Question: Judging by this figure, is the value going up or going down?
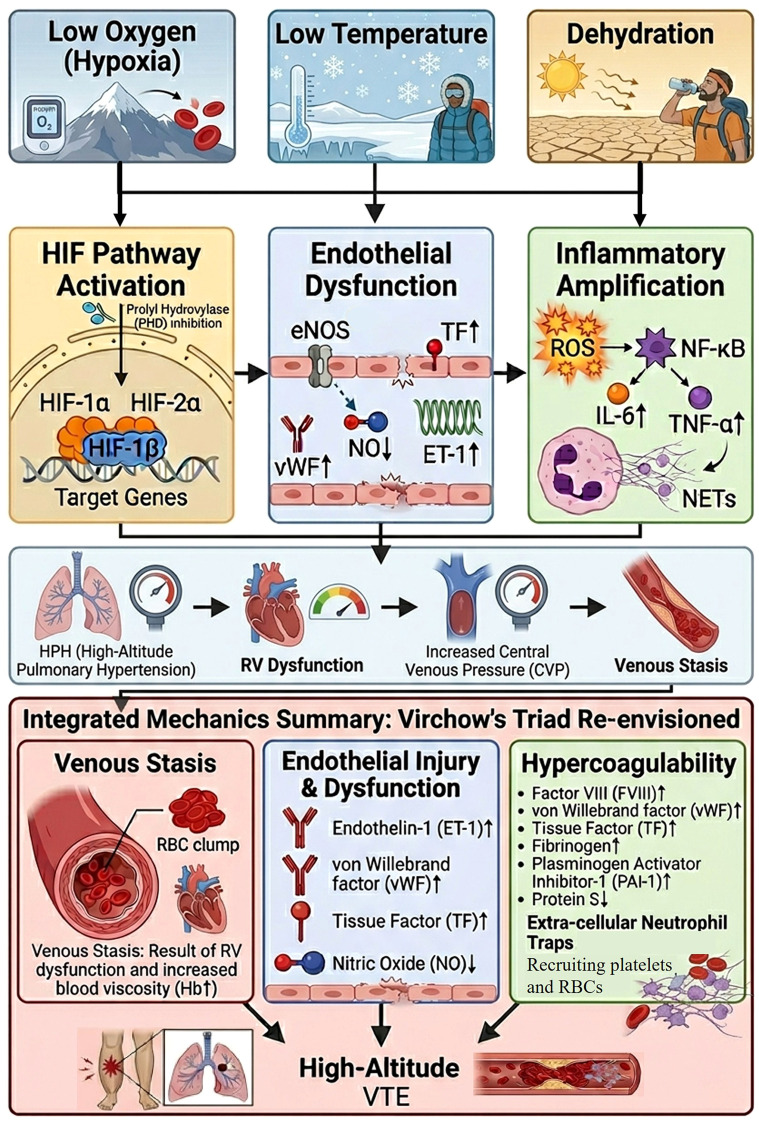
Answer: increasing